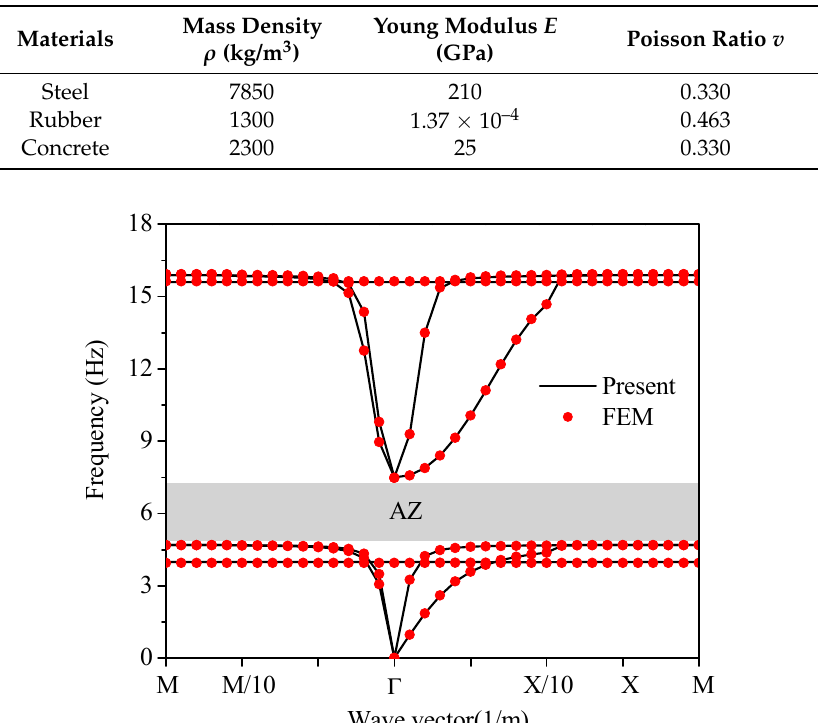
Figure 3. Dispersion curves of in-plane waves in a 2D locally-resonant periodic foundation.